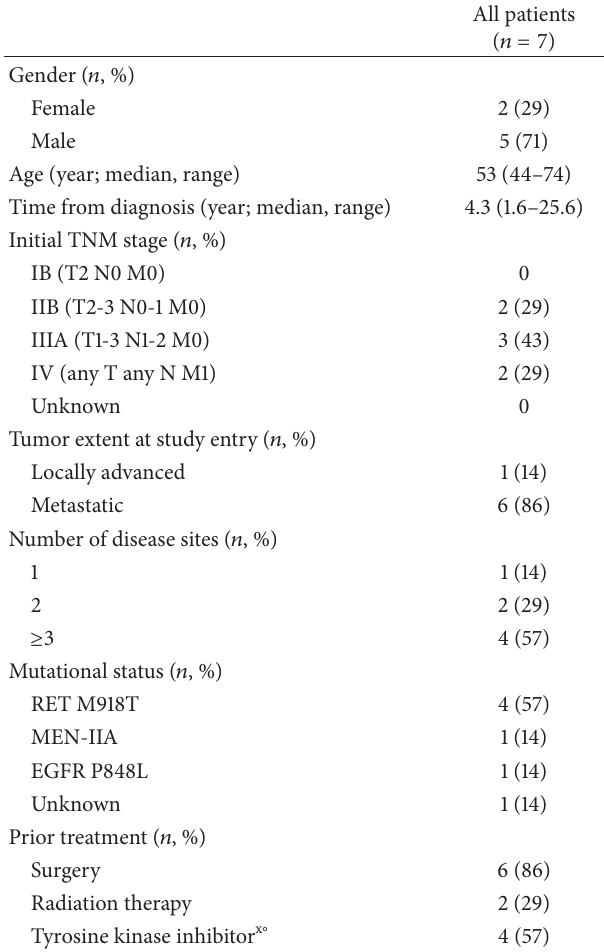
Table 1: Baseline characteristics.